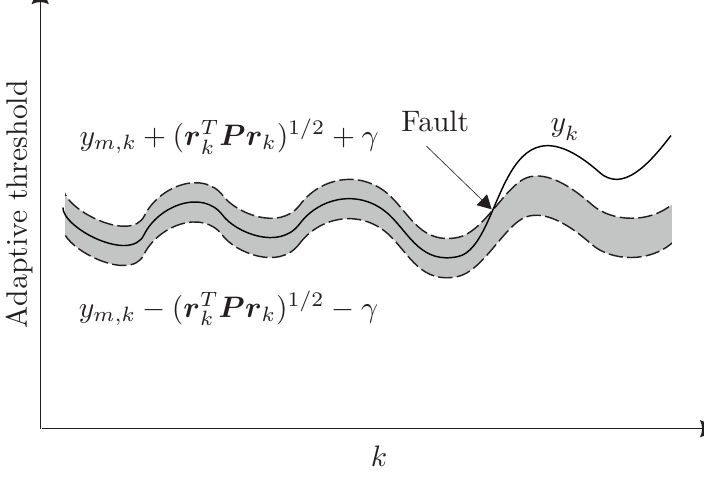
Figure 5. The adaptive threshold in the